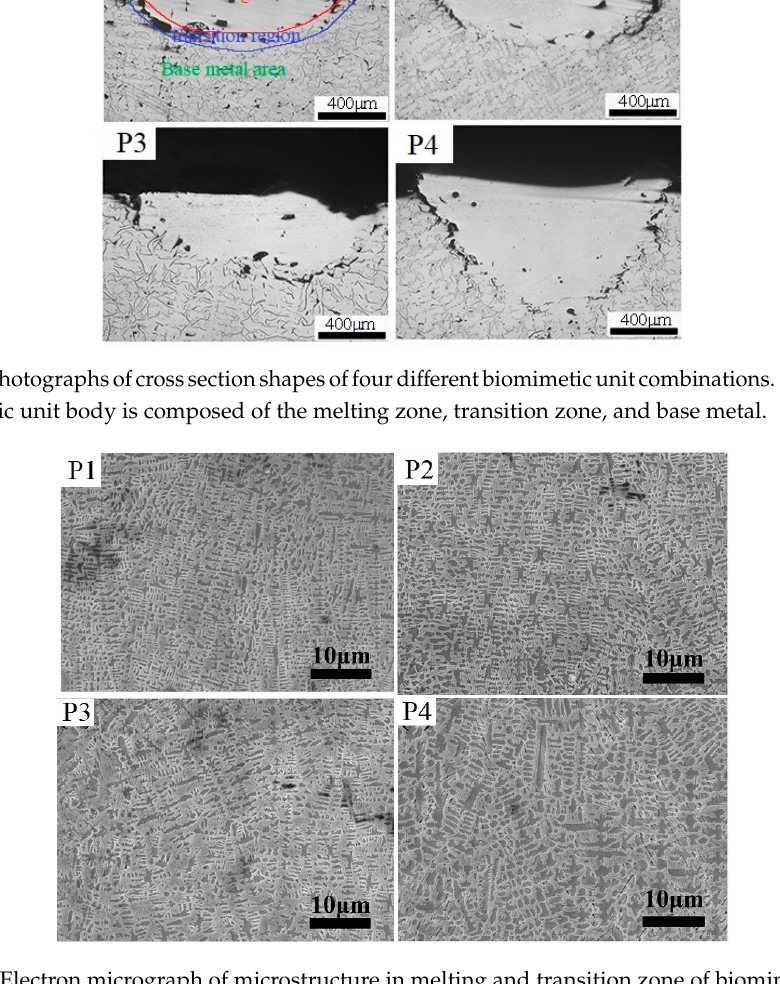
Figure 8. Electron micrograph of microstructure in melting and transition zone of biomimetic unit.